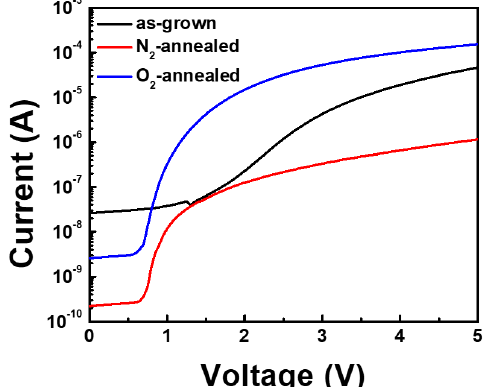
Figure 4. Current–voltage (I-V) characteristics of the AlN film Schottky barrier diode (SBD) devices obtained before and after annealing.